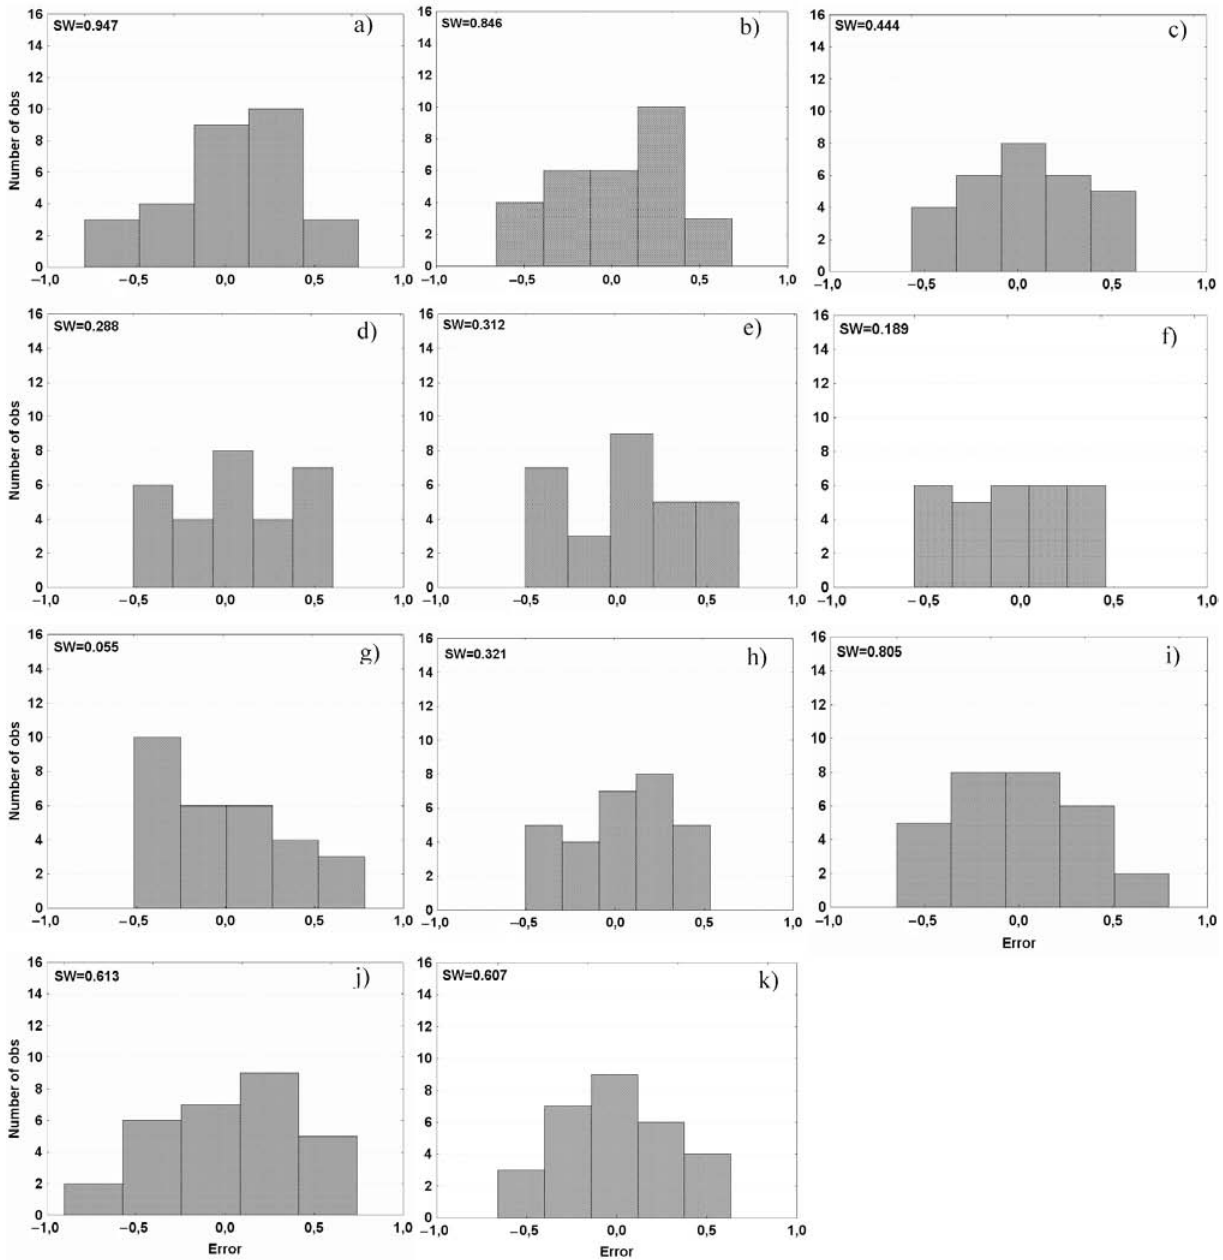
Fig. 5. Histogram of the errors resilting from: a) IDW1; b) IDW2; c) IDW3; d) IDW4; e) IDW5; f) LP1; g) LP2; h) SPT; i) TPS; j) OK; k) COK. SW(Shapiro-wilk test). Normal distribution considered at a